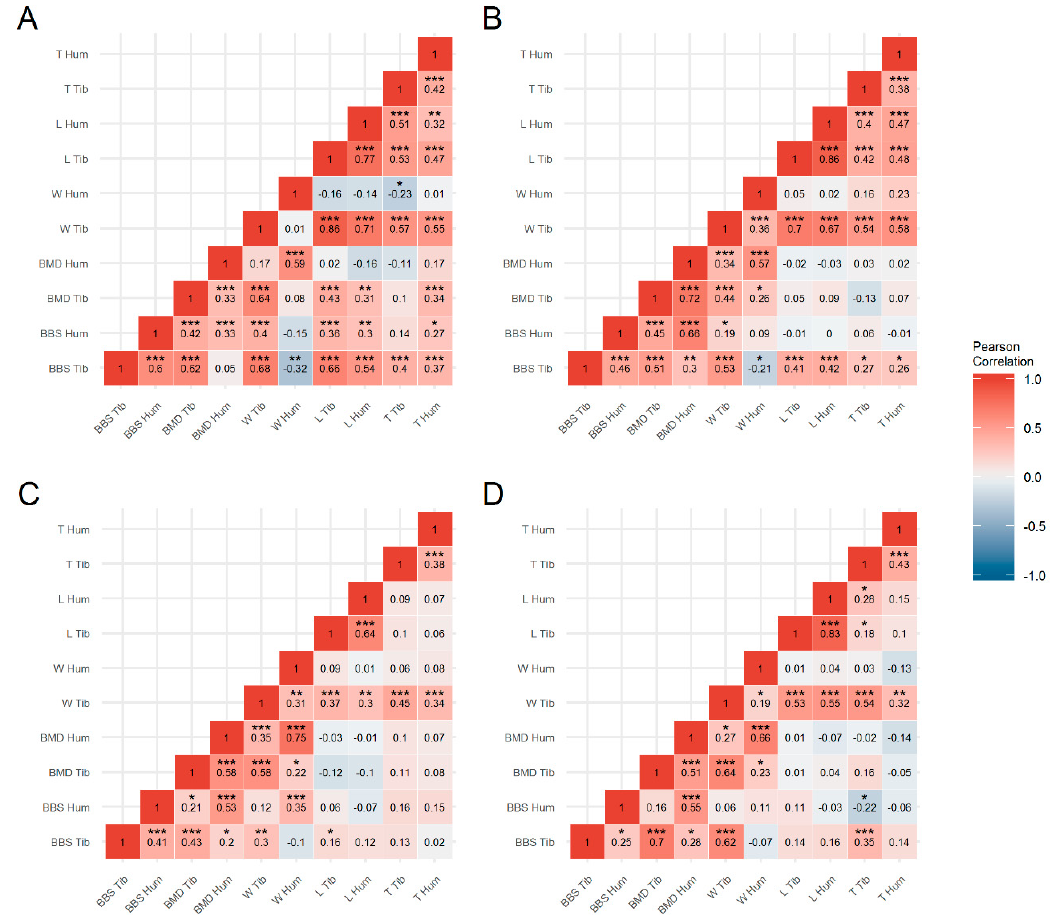
Figure 2. Heatmap of Pearson’s correlation coefficients between bone traits (BBS, bone breaking strength; BMD, bone mineral density; W, bone weight; L, bone length; T, bone thickness) of the tibiotarsus (Tib) and humerus (Hum) in laying hens of the genetic lines WLA ( A ), R11 ( B ), BLA ( C ) and L68 ( D ). Red indicates a positive correlation; white represents no correlation and blue represents a negative correlation. Significant correlation coefficients are marked with asterisks (* p < 0.05; ** p < 0.01; *** p < 0.001).